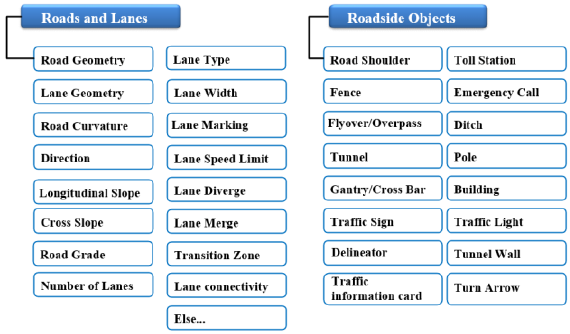
Figure 2. The detailed map properties of the HADMs